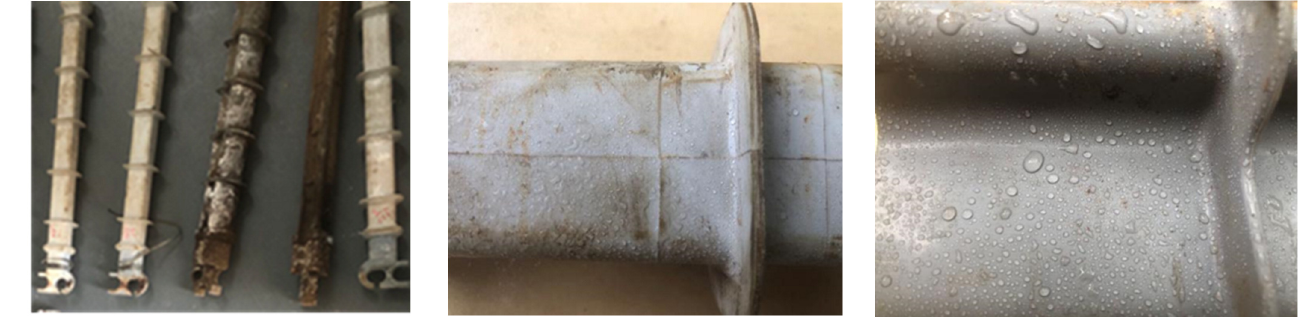
Figure 3. Morphology of two kinds of composite cross-arm samples after multi-factor aging.